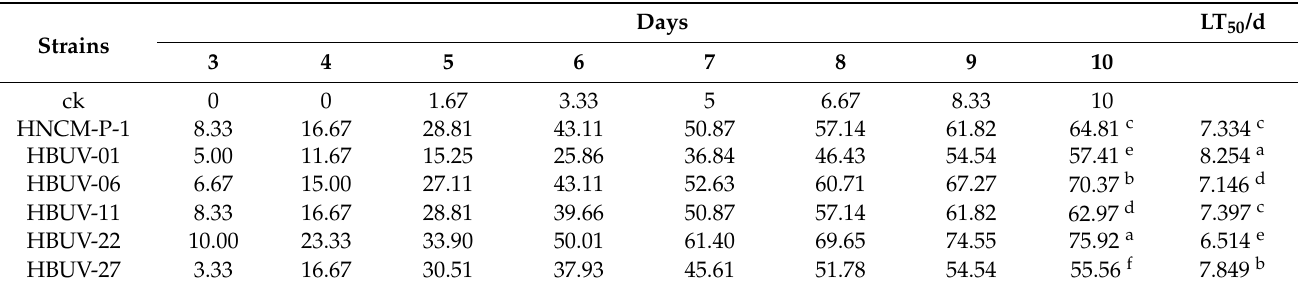
Table 2. Corrected mortalities (%) and LT 50 of P. bilinealis treated with positive UV-mutant strains of B. bassiana